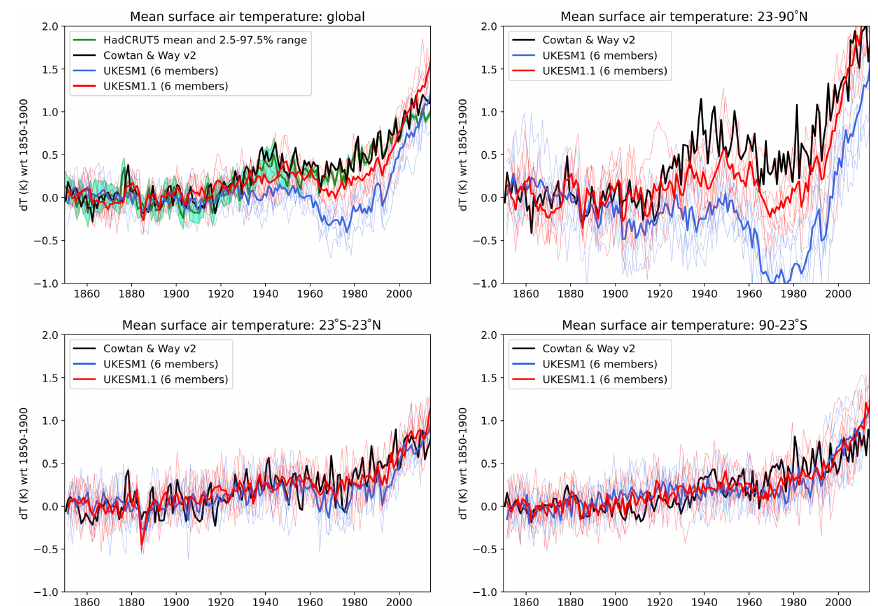
Figure 3. Annual mean surface temperature anomaly relative to 1850–1900 mean for the full globe, Northern Hemisphere extratropics (23– 90 ◦ N), tropics (23 ◦ S–23 ◦ N) and Southern Hemisphere extratropics (90–23 ◦ S). Thin lines are the individual historical ensemble members of UKESM1.1 (red) and UKESM1 (blue); the thick line is their ensemble mean. The Cowtan and Way (2014) temperature reconstructions are plotted in black, and for the full globe, the HadCRUT.5.0.1.0 mean and 2.5%–97.5% uncertainty range (Morice et al., 2021) are shown in dark green and aquamarine. Model time series are detrended using the linear trend of the preindustrial control over the equivalent period.